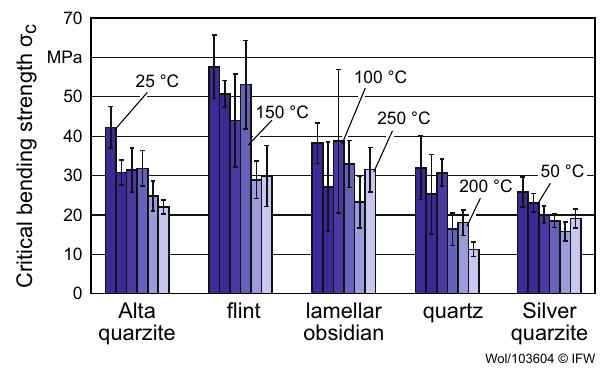
Fig. 4 Critical bending strength of the rocks at different tempera- tures